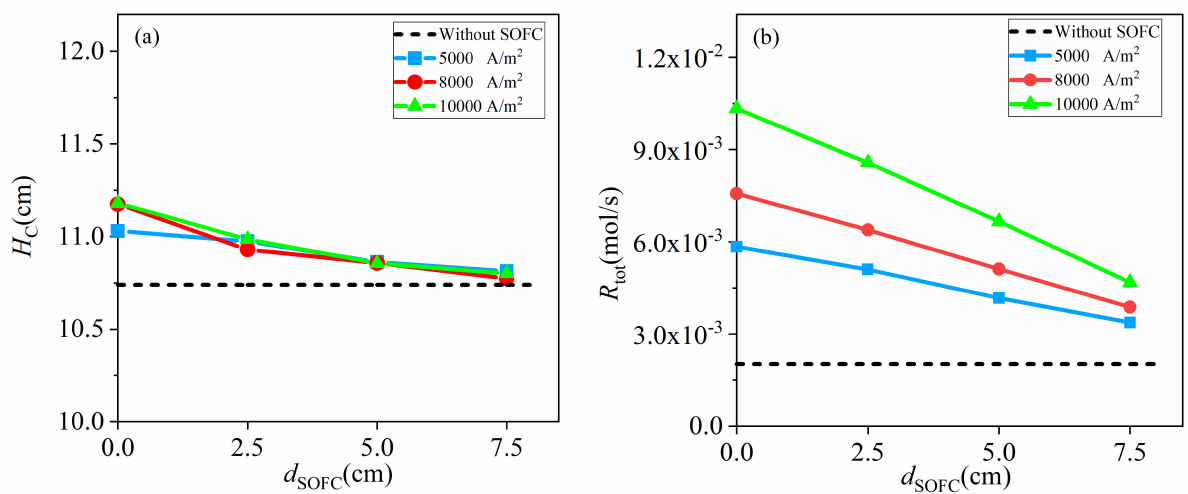
Figure 12. ( a ) Carbon bed height, H C and ( b ) total gasification rate, R tot of fluidized bed coupled with SOFC with A s = 7.2 × 10 − 5 mol/m 2 , v CO = 0.5 2 ,in